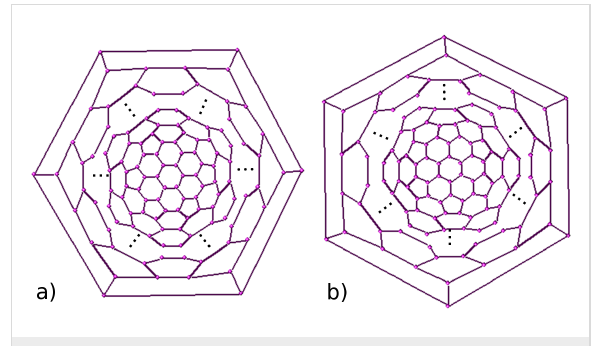
Figure 1: The Schlegel diagram of F n , (a) n is even; (b) n is odd.